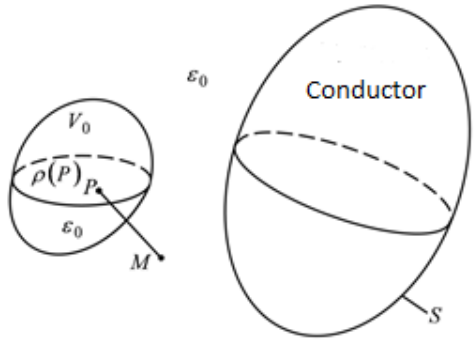
Figure 3. A conducting body bounded by a closed surface S carrying a charge q is introduced into the field of charges located in volume V 0 .